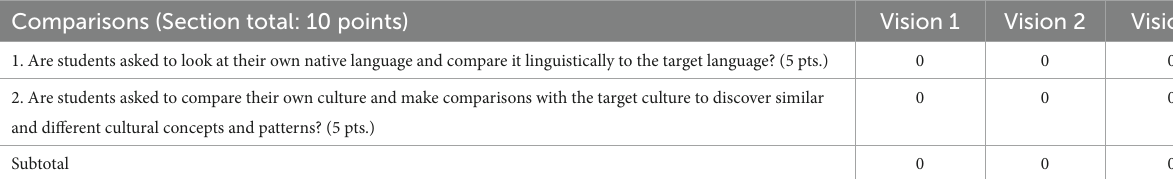
TABLE 3 Evaluation of Vision Series textbooks based on comparisons. Comparisons (Section total: 10 points)